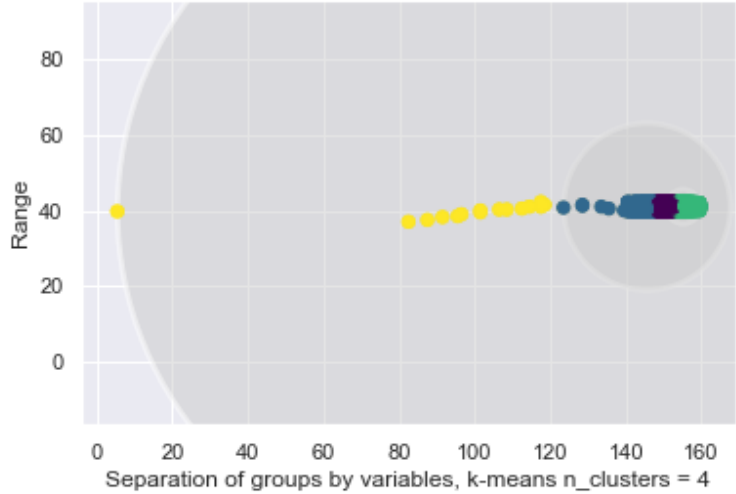
Figure 18. Delimited groupings for 4 labels and 2 variables.